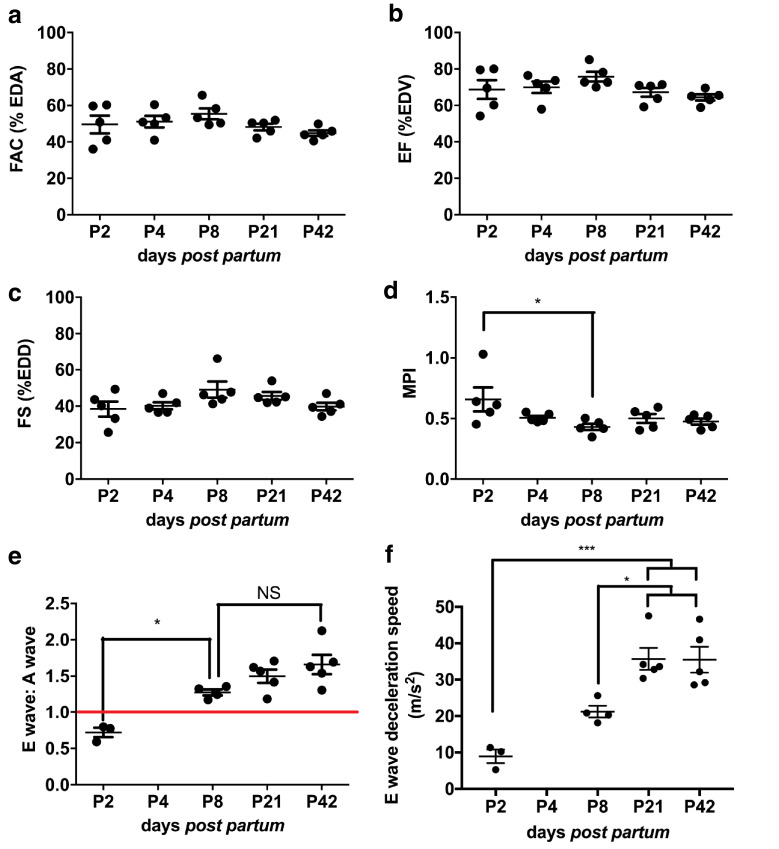
Cardiac systolic function is stable throughout postnatal cardiac structural changes. Cardiac systolic function was investigated using high-resolution in vivo electrocardiogram-gated kilohertz visualisation (EKV) ultrasound imaging at post-natal day 2 (P2), P4, P8, P21 and P42. EKV B-mode allowed calculation of (a) fractional area change (FAC) and (b) ejection fraction (EF). (c) Parasternal long axis (PLAX) M-mode was used to obtain fractional shortening (FS). Mid-ventricular pulse wave Doppler waveforms enabled calculation of the myocardial performance index (MPI) (d) as well as the diastolic function parameter of E to A wave ratio (e) and E wave deceleration (f); n = 3–5/group. Results are presented as mean ± standard error of the mean. p-value determined with one-way analysis of variance with Bonferroni post hoc test. *p < 0.05, ***p < 0.001.